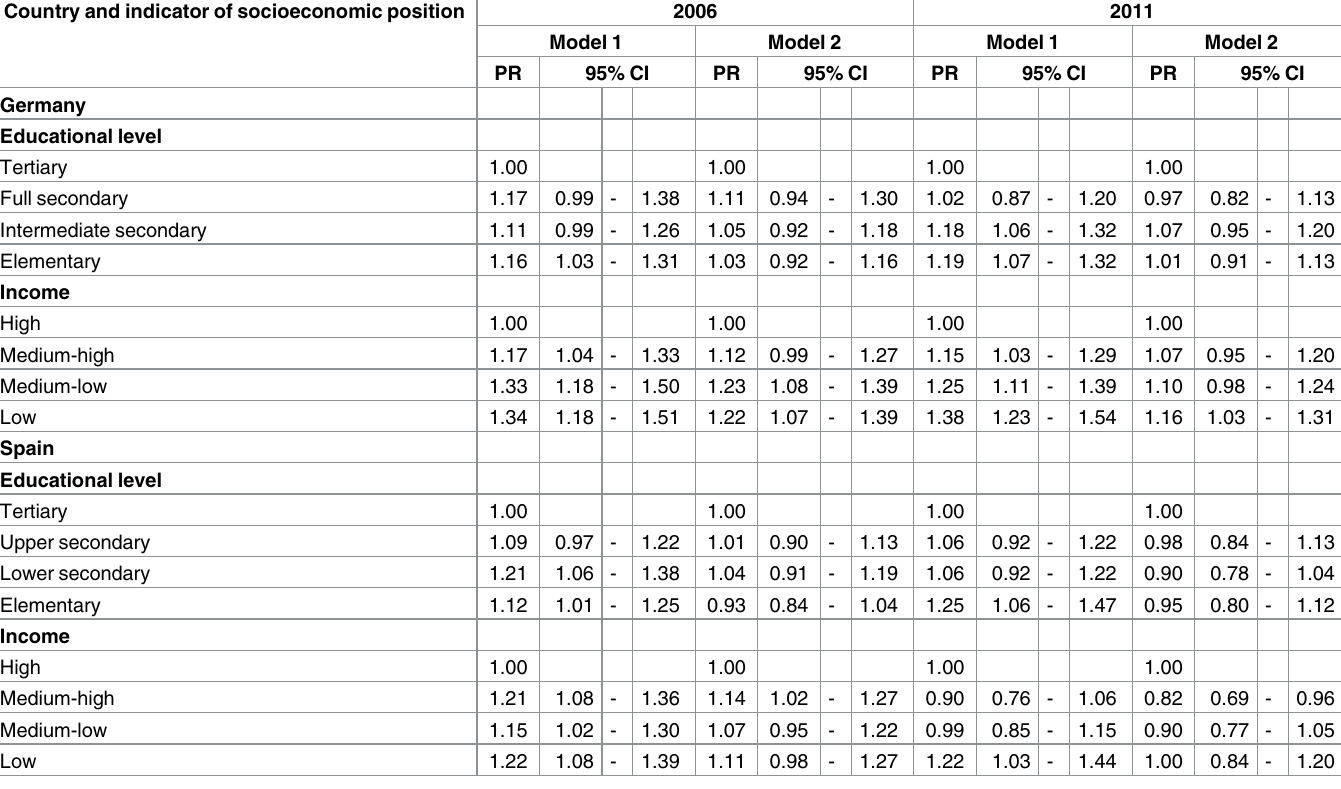
Table 4. Hospitalization in the last year by educational level and income. Percentageratio (PR) and 95% confidenceinterval(95% CI). Country and indicator of socioeconomic